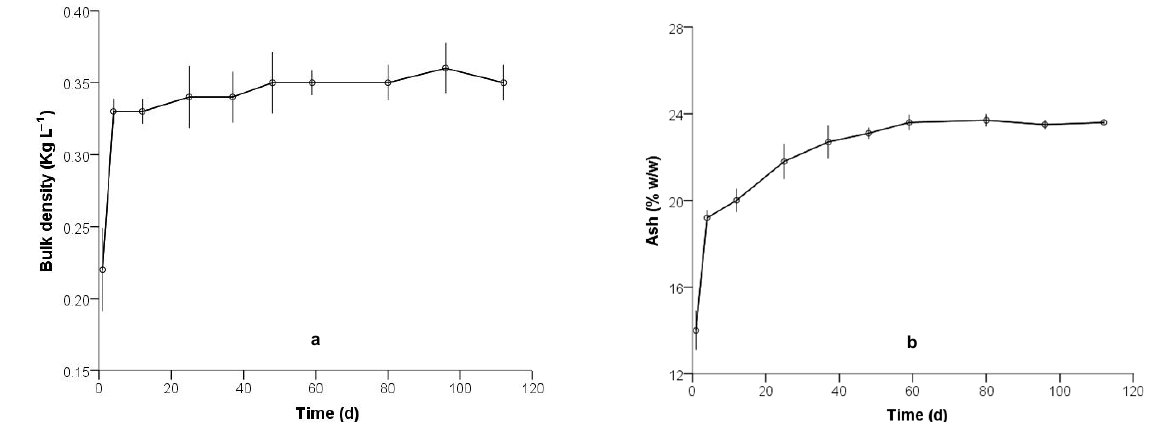
Figure 3. Variations in the bulk density ( a ) and ash content ( b ) of the biotreated OMW with time. Error bars were placed at the 95% confidence level.